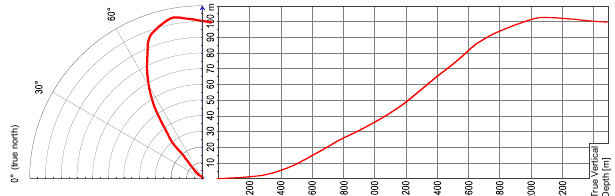
Figure 8. The COSC-1 drill hole deviation, seen from above (with azimuth) and plotted vs. depth: 10 × horizontal exaggeration.